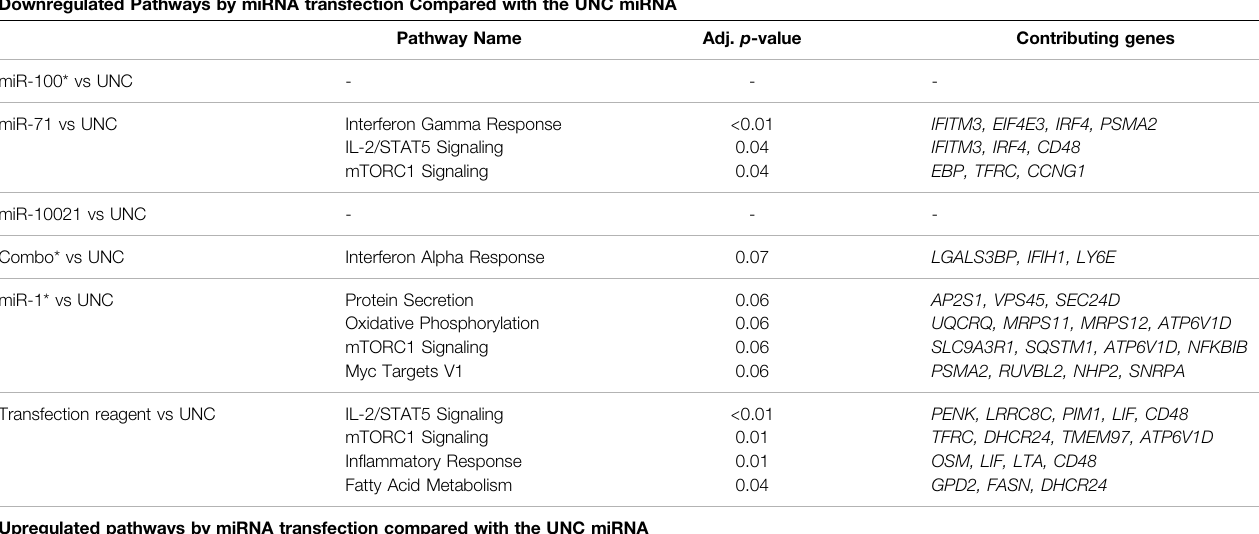
TABLE 1 | Most strongly up- and downregulated pathways. DE genes (p < 0.01) were submitted to Enrichr for pathway enrichment against the MSigDB Hallmark 2020 library. Combo: combination of miR-100, miR-10021, and miR-71 in equal parts, where the total amount of miRNA introduced is the same as for individual miRNAs (i.e., 10 nM). UNC: universal negative control. Data for miR-100, miR1 and combo are from two independent experiments only. Downregulated Pathways by miRNA transfection Compared with the UNC